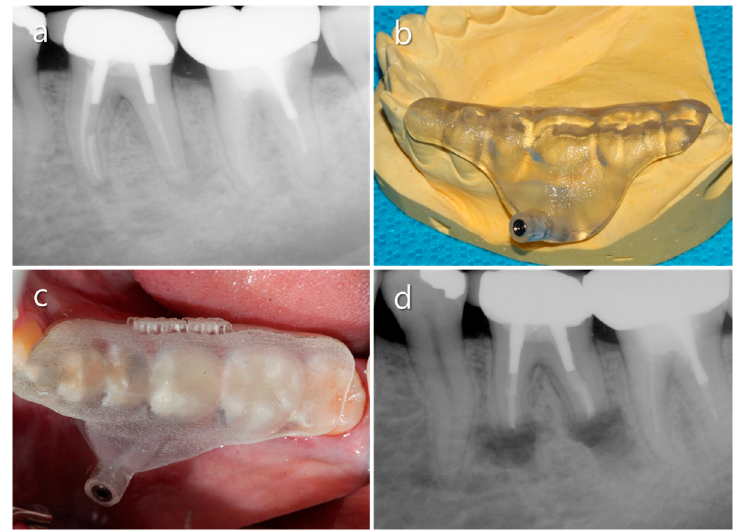
Figure 2. Clinical case using a computer-aided design/computer-aided manufacturing (CAD/CAM)-guided surgical template to localize the root apex through thick. ( a ) Diagnostic periapical X-ray. ( b ) A manufactured surgical template. ( c ) The surgical template was positioned on the tooth. ( d ) Postoperative radiograph.